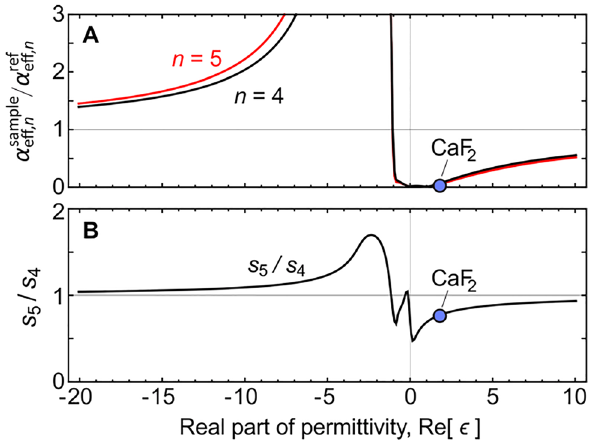
Figure 3: Calculated normalized s-SNOM signals. (A) Normalized n th Fouriercoef fi cientsof the effectivepolarizability, α sample / α ref , as a function of Re[ ϵ ], where ϵ is the complex-valued eff , n eff , n dielectric function of the sample with Im[ ϵ ] = 0.2. As reference materialwehavechosenAu. (B)Amplituderatio s 5 / s 4 obtainedfrom data of panel (A). Calculated using the fi nite dipole model for a tapping amplitude A = 75 nm and tip radius R = 30 nm (see Methods section). For comparison, blue symbols show experimental data obtained from Figure